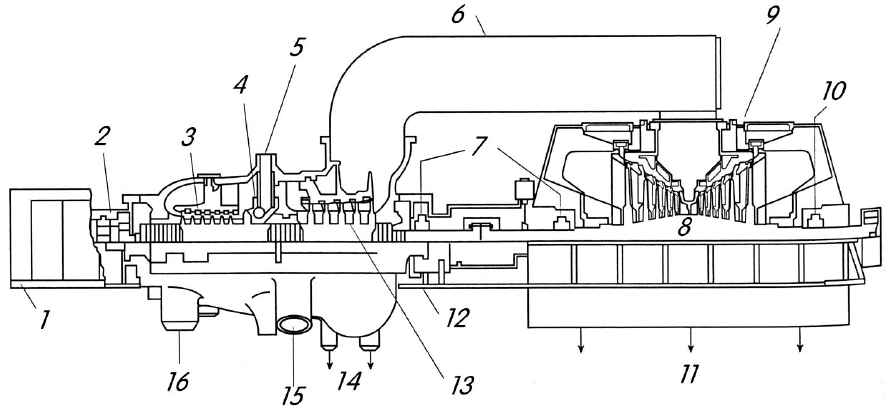
Figure 2. Typical tandem compound, single reheat, condensing turbine: 1 —front pedestal; 2 —thrust and journal bearing; 3 —high pressure stages; 4 —nozzle box; 5 —HP turbine inlet; 6 —crossover piping; 7 —journal bearings; 8 —rotor; 9 —low pressure stages; 10 —journal bearing; 11 —to condenser; 12 —pedestal; 13 —intermediate pressure stages; 14 —extractions; 15 —IP turbine inlet; 16 —to reheater [2].